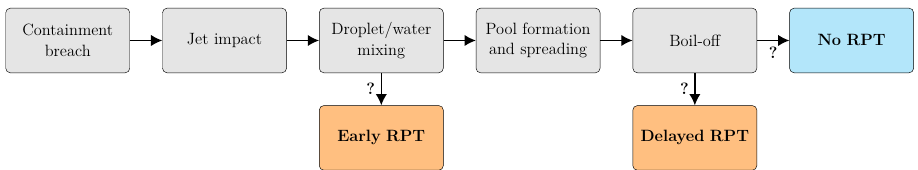
Figure 2. The macroscopic chain-of-events in an LNG spill on water from a containment breach to the possible outcomes, including the two types of RPT events. Uncertain pathways are indicated by question